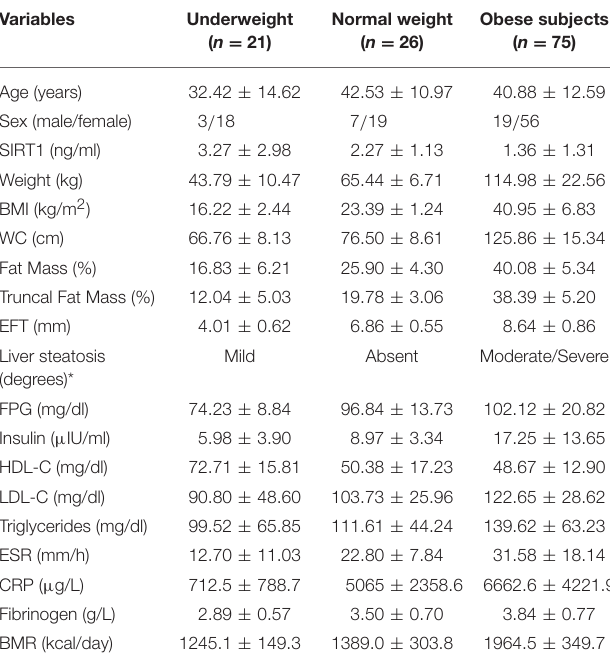
TABLE 1 | Demographic, anthropometric and clinical characteristics of the patients.